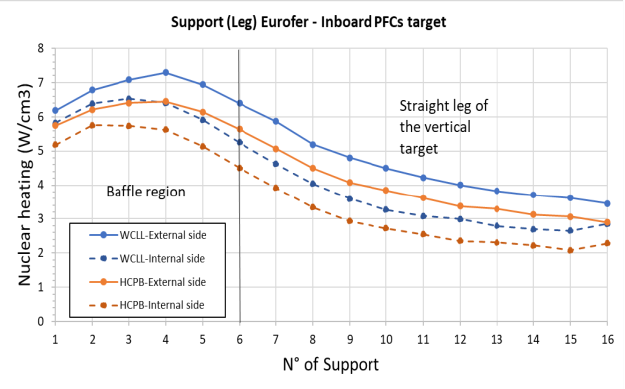
Figure 44. Inner poloidal profiles of the nuclear heating (W/cm 3 ) on PFC-CB supports made of Eu-